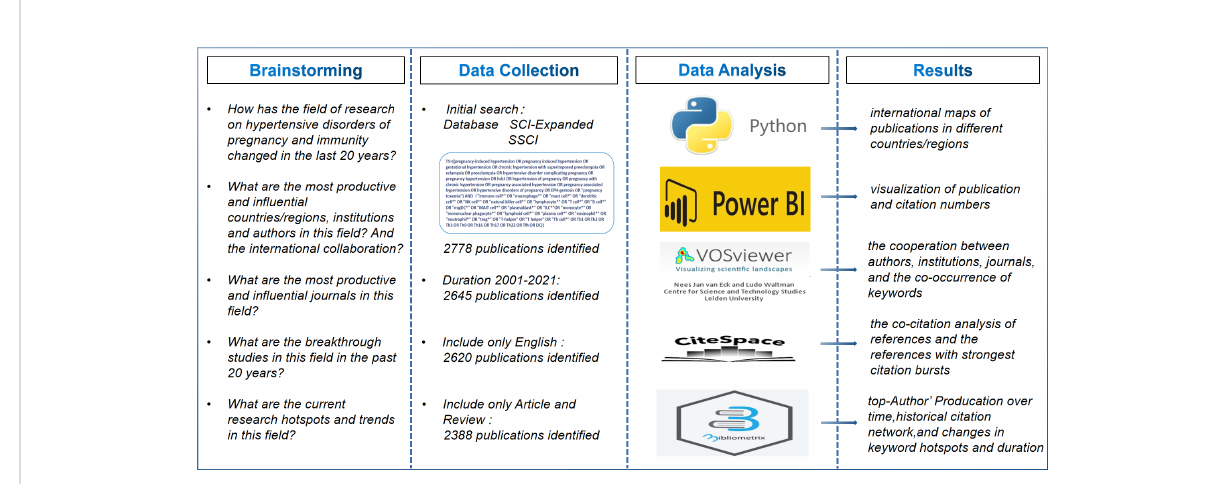
FIGURE 1 Conceptual design of the entire